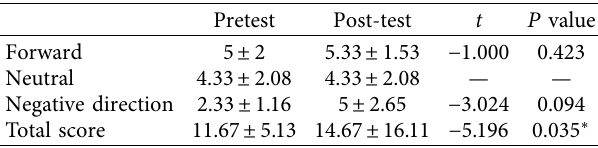
Table 3: Comparison before and after AMT